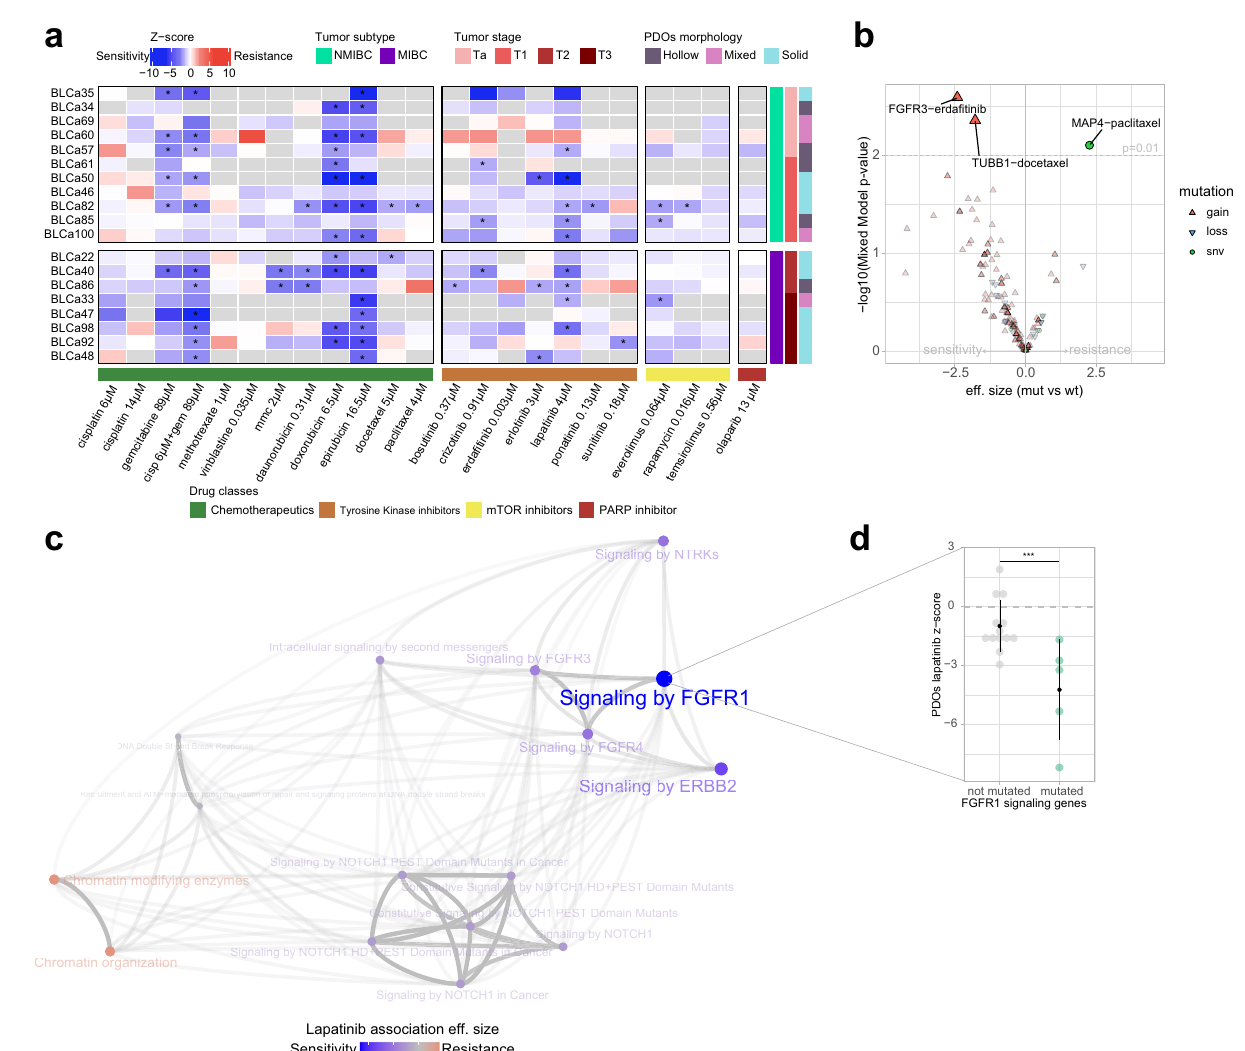
Fig. 5 | Patient-derived organoid (PDO) drug response and association with gene alterations. a Results of PDO drug screen assay ( n =19 biological samples). Heatmapreportstheaverageofz-scoresnormalizedtothevehiclevaluesfromcell viability assays after 48h exposure of PDOs to drugs for one experiment for each biologicalsample(rawdataareprovidedinSupplementaryData6).Tumorsubtype andstage,andPDOmorphologyareindicatedindifferentcolorsontherightofthe heatmap; not available data are in gray. Statistically signi fi cance between treat- ments and vehicle was calculated by one-way ANOVA test with Dunnet ’ s multiple comparison, *z-score ≤− 1.5 and adjusted p -value ≤ 0.05. b Genomic association analysis between genomic somatic events and treatment sensitivity/resistance. Reported p -value is obtained through Linear Mixed Model (LMM) fi t (see “ Meth- ods ” , section drugs association analyses) without adjusting for multiple